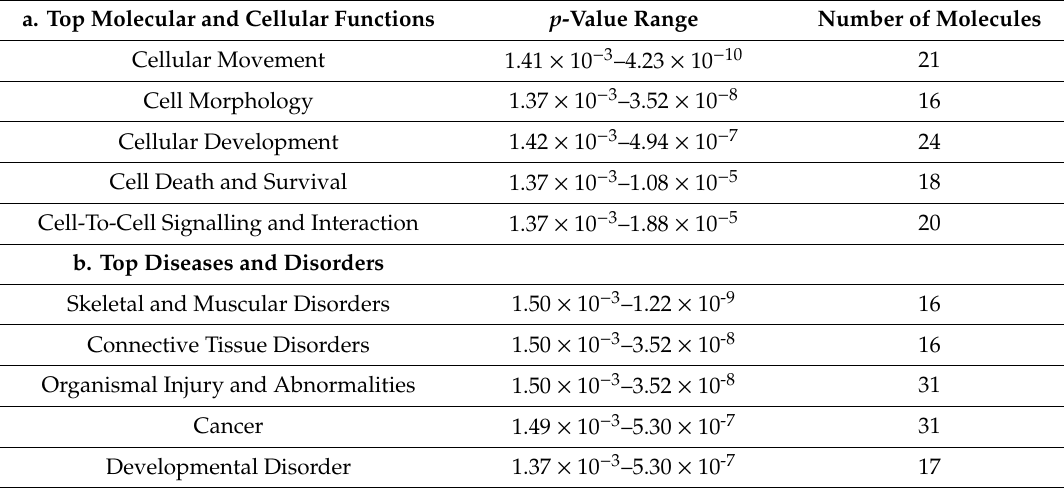
Table 2. IPA mRNA target diseases and functions.